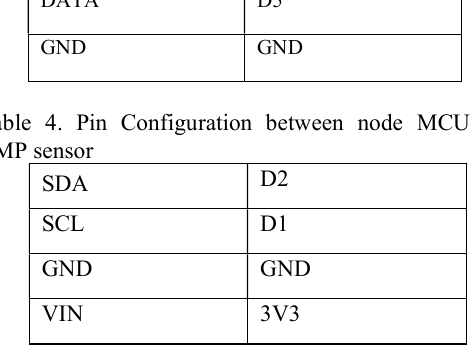
Table 5. Pin Configuration between node MCU and